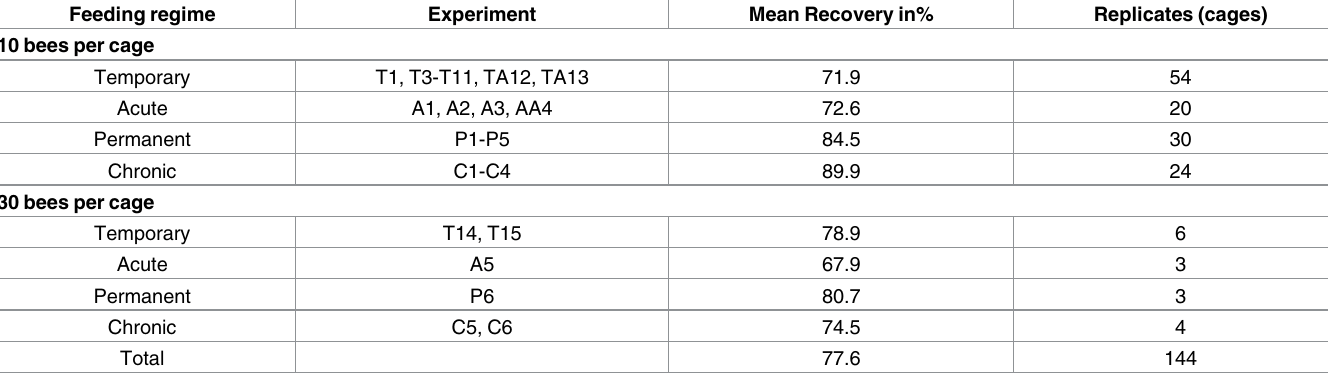
Table 2. Recoveryof 14 C PEG for the different applied feeding regimes. Mean recovery of 14 C labelledsugar solution diet and numberof replicatesfor experimental setups with 10 or 30 bees for temporary 1 (T) and permanent 2 (P) feedingregimes without imidacloprid and for acute 3 (A) and chronic 4 (C) feed- ing regimeswith